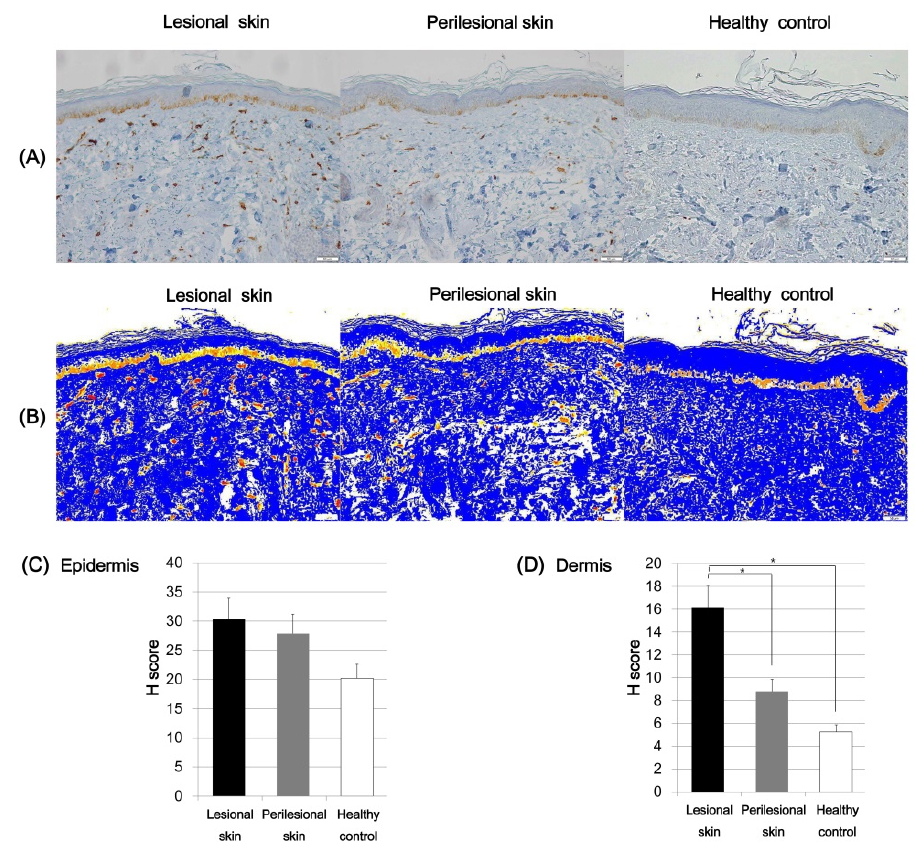
Figure 5. Expression profiles of c-kit in the lesional and perilesional skin of Riehl’s melanosis and healthy controls. ( A ) The dermal expression of c-kit was increased in the lesional skin of Riehl’s melanosis (original magnification, 200 × ). Scale bar, 50 µ m. ( B ) Densitoquant TM quantitatively measured the intensity of c-kit expression in Riehl’s melanosis and healthy control as follows: red, strong positive; orange, moderately positive; yellow, weakly positive; white and blue, negative. ( C ) The mean H score for epidermal c-kit expression intensity was quantitatively evaluated in the lesional and perilesional skin of Riehl’s melanosis and healthy controls. ( D ) The mean H score for dermal c-kit expression intensity was quantitatively analyzed in the lesional and perilesional skin of Riehl’s melanosis and healthy control. * indicates p value less than 0.05.